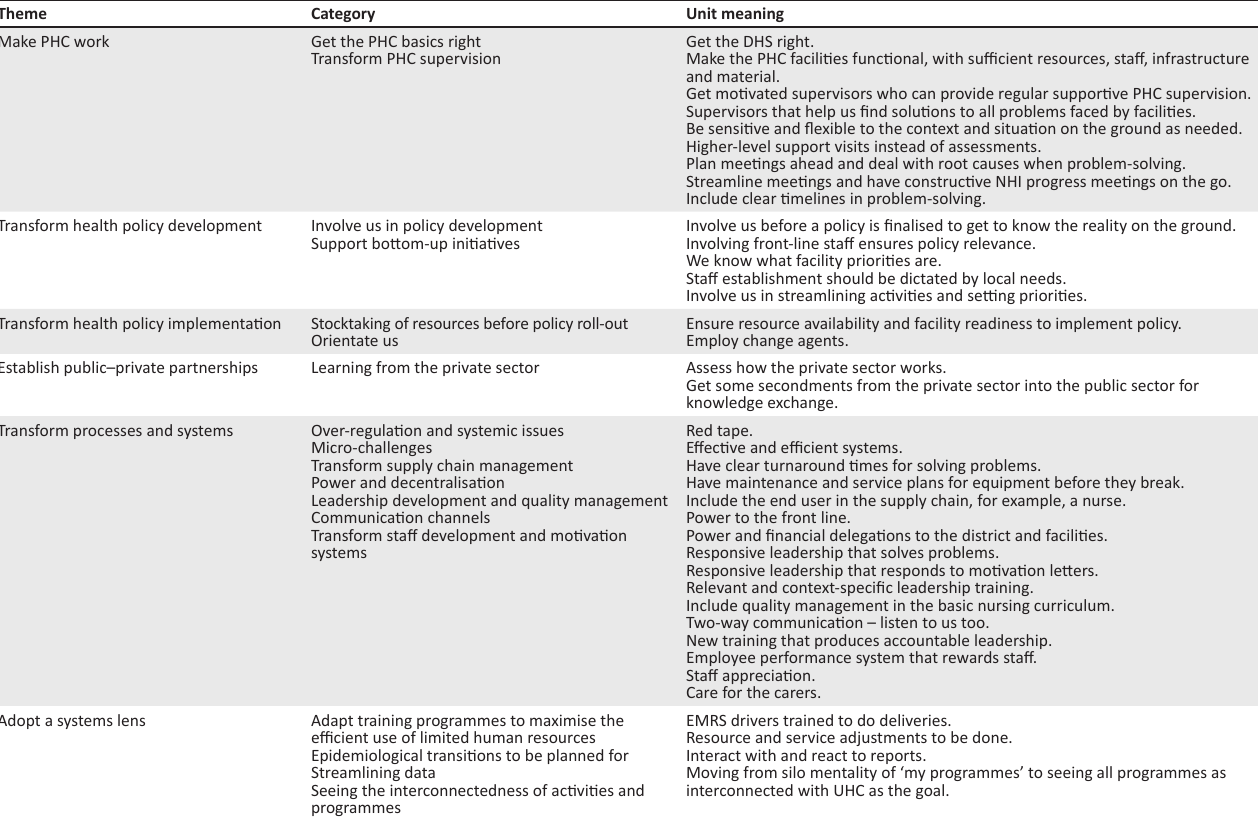
TABLE 2: Summary of emergent deductive and inductive themes.